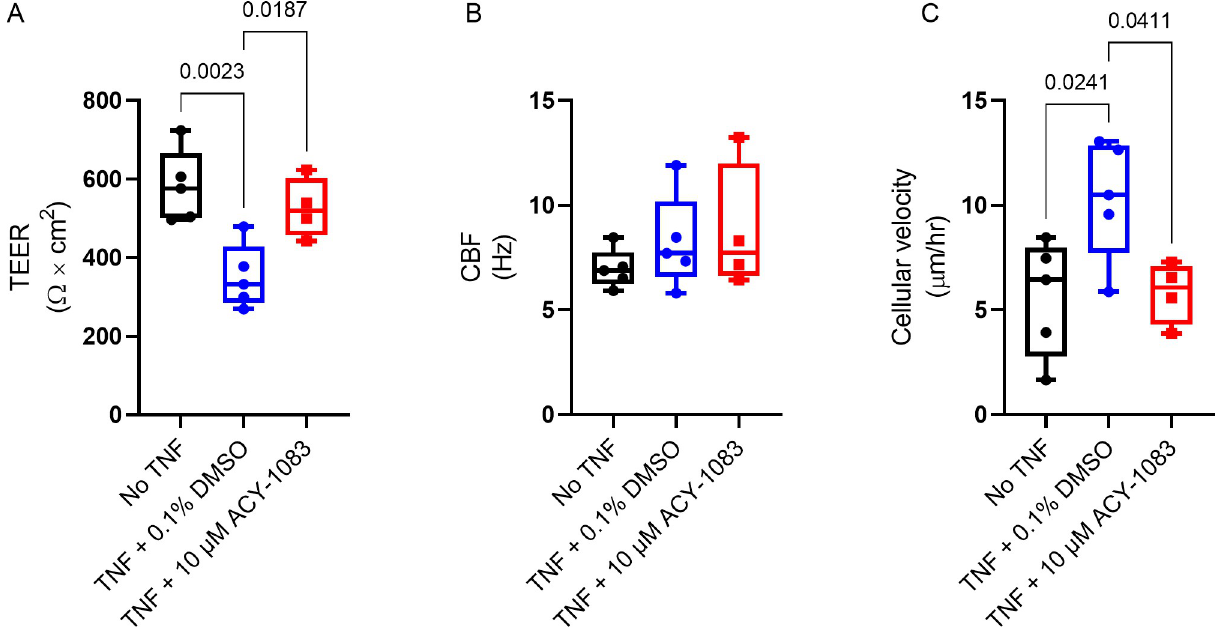
Fig 7. ACY-1083 preserves epithelial plasticity phenotypes induced by TNF. Epithelial plasticity phenotypes were determined by measuring (A) TEER, (B) CBF and (C) Cellular velocity of unchallenged and TNF-challenged healthy HBEC at ALI cultures with and without ACY-1083 treatment. Box plot with dots representing the average of triplicates for 3 healthy HBEC donors (unchallenged and TNF + 0.1% DMSO) and the average of triplicates for 2 donors (TNF + ACY-1083) and whiskers showing min and max. Statistical analysis was performed using one-way ANOVA with Dunnett ´s multiple comparisons